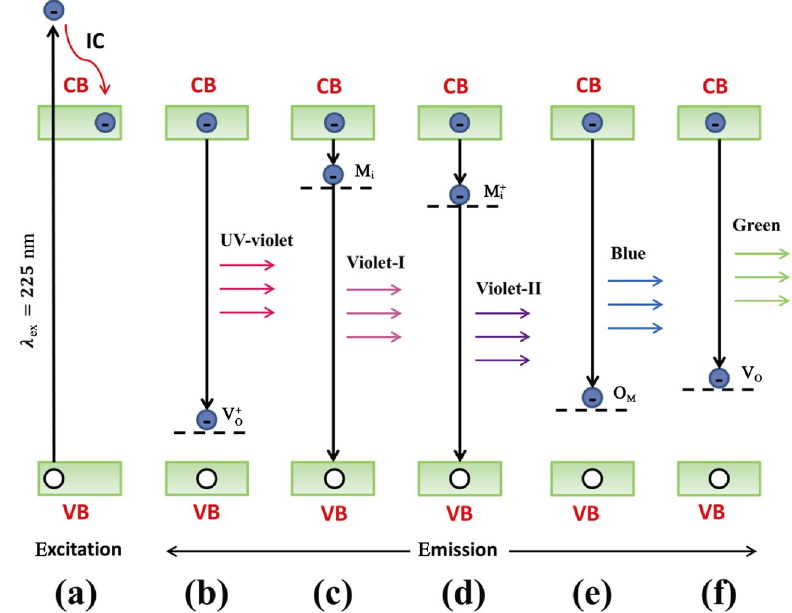
Fig. 9 Fluorescence mechanism, presenting various PL emission components originated due to electronic transitions between different defect levels and the band edges of aluminate